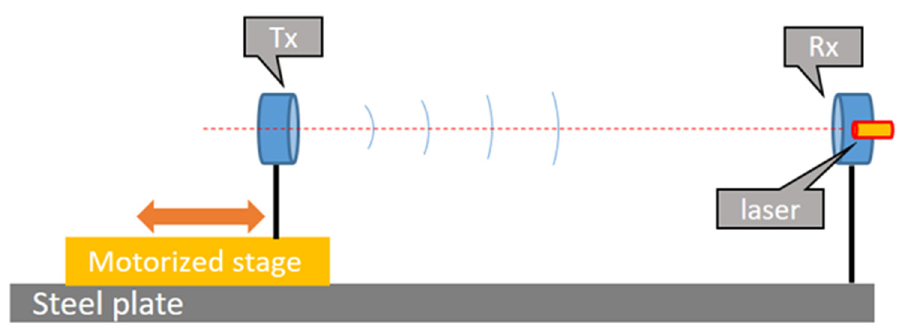
Figure 1. Simplified schematic of the CAT. Details are given in the text. A simplified schematic of the electronic set ‐ up is shown in Figure 2.